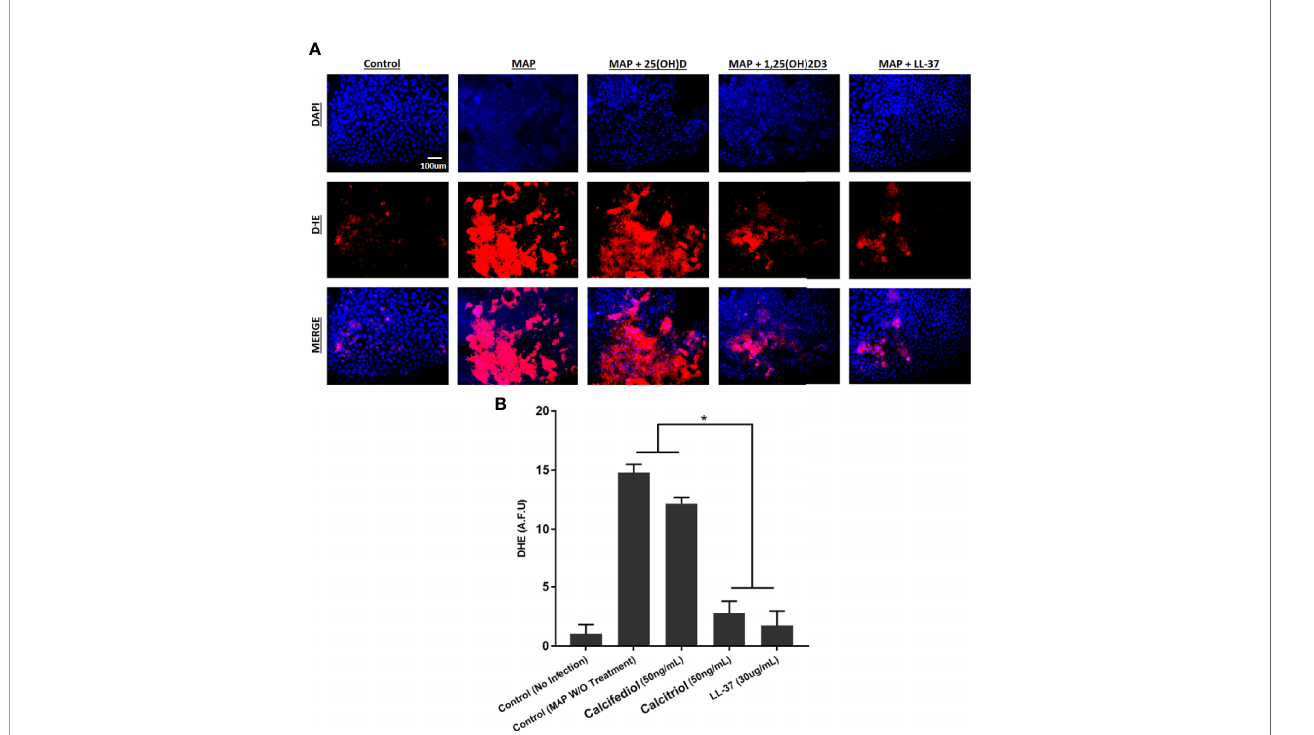
FIGURE 10 | (A) The impact of calcitriol and LL-37 treatment on oxidative stress measured by co-cultured Caco-2 monolayers. Total nuclei are stained with DAPI in blue. DHE positive cells are stained in red, and merged cells are presented in pink. (B) Quantitative corrected DHE fl uorescence integrated density from control and treated groups. *Indicates P-value of less than 0.05.